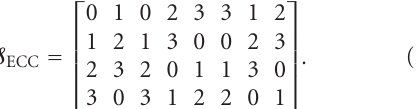
subcarriers within the subblocks. The subblocks obtained using ECCs over Z 4